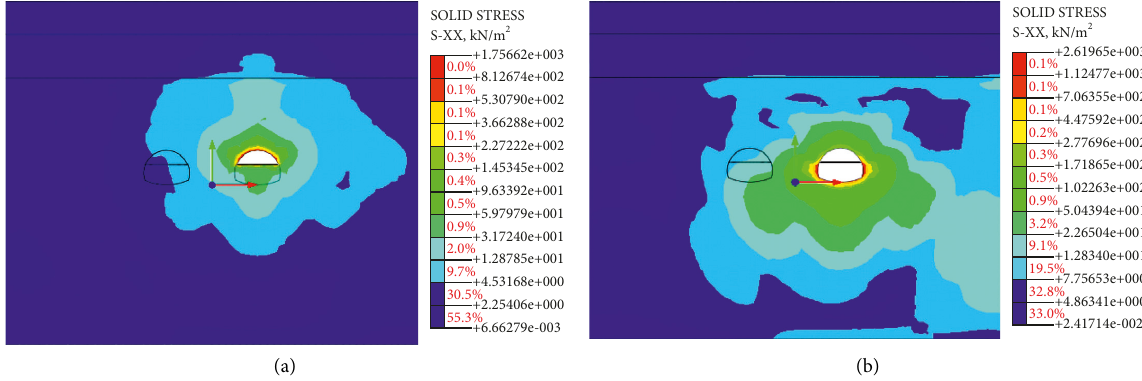
Figure 23: Stress distribution of surrounding rock (tunnel clear distance D). (a) Excavation of upper step and (b) excavation of lower step.